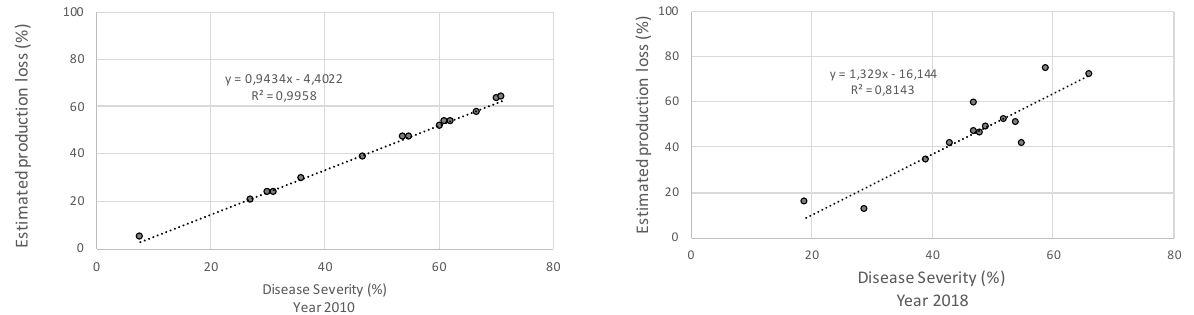
Figure 4. Regression analyses between severity of Botryosphaeria dieback (measured in spring) in ‘Cabernet Sauvignon’ vineyards located in the O’Higgins and Maule Regions, Central Chile. A) Production losses (%), estimated in 2010 by number of dead spurs; and B) Production losses (%), estimated in 2018 by harvesting plants with different degrees of disease